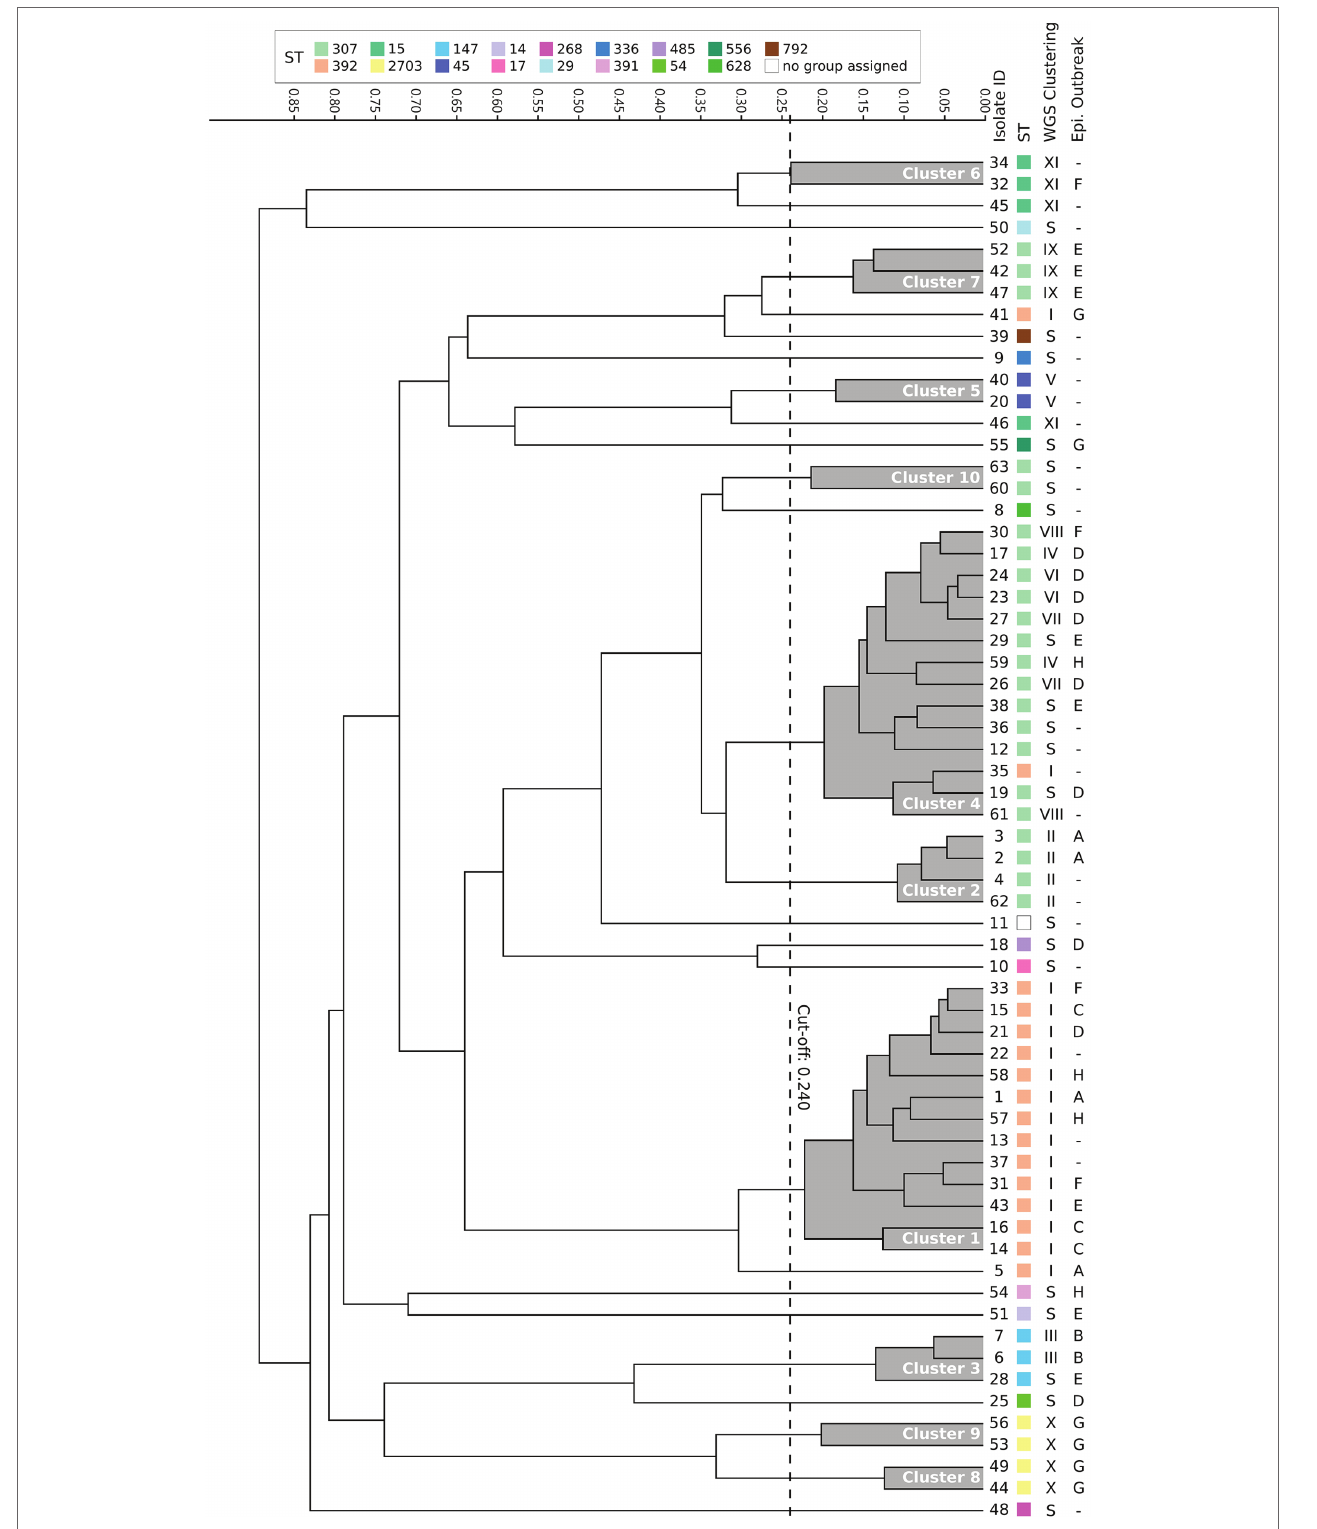
FIGURE 3 | Dendrogram obtained by clustering the Fourier transform infrared spectroscopy (FTIR) spectra of 63 extended-spectrum β -lactamase-producing K. pneumoniae isolates. The vertical dashed line indicates the used cutoff value (0.240). Resulting FTIR clusters (1–10) are shadowed in gray. Corresponding sequence type (ST), WGS cluster, and epidemiological outbreak are indicated for each isolate. S,